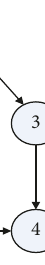
Figure 3: The graph G 2 .